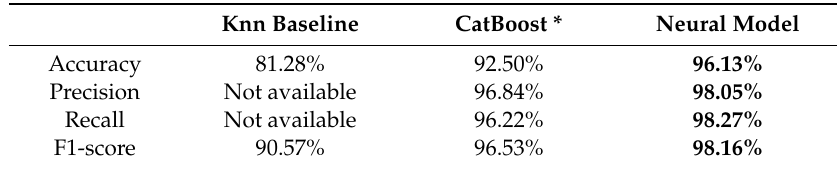
Table 7. Afrikaans compound analysis accuracy (word level) and F1-scores (constituent boundaries); numerically highest scores are in bold